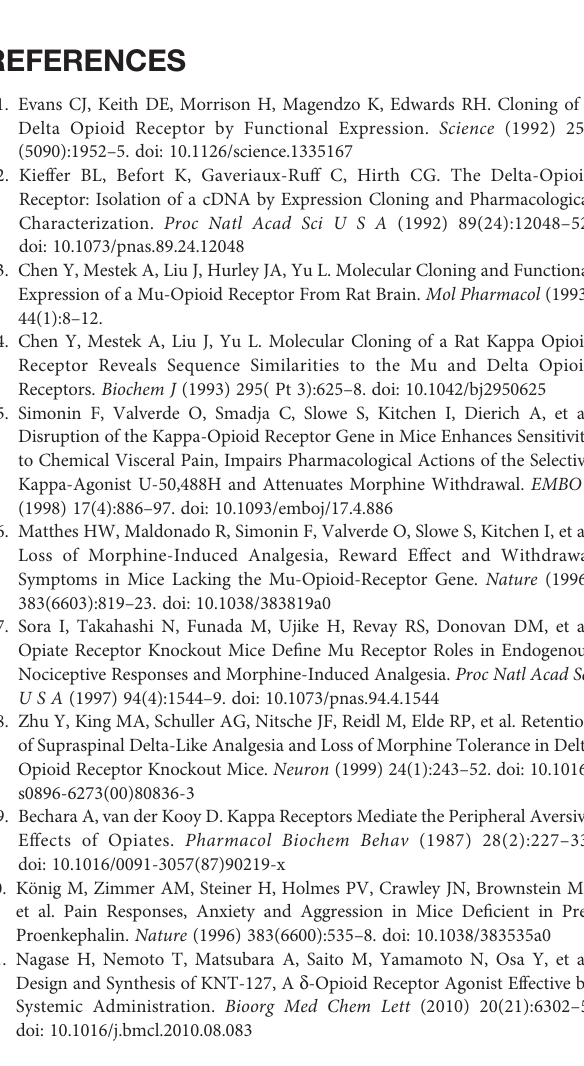
gene of interest was normalized to that of GAPDH by calculation of cycle threshold values. (A) mRNA levels of antimicrobial peptides. (B) mRNA levels of tight junction proteins. (C) mRNA levels of tissue restoration factors. The data are shown as the mean±s.e.m. ** P < 0.01; *** P < 0.001; **** P < 0.0001; n.s., not signi fi cant (one-way ANOVA followed by Dunnett ’ s multiple comparisons test, vs vehicle). Supplementary Figure 3 | Changes in intestinal factors (control mice). The colon was collected from healthy mice 24 h after treatment with 5 mg/kg KNT-127 or vehicle. The mRNA expression of each gene of interest was normalized to that of GAPDH by calculation of cycle threshold values. (A) mRNA levels of antimicrobial peptides. (B) mRNA levels of tight junction proteins. (C) mRNA levels of tissue restoration factors. The data are shown as the mean±s.e.m. n.s., not signi fi cant (Two-tailed Student ’ s t-test). Supplementary Figure 4 | Frequency of CD4+ T cell subtypes in the MLNs (colitis recovery model). The MLNs were collected from colitis mice on day 12. The frequencies of IL-6 + -, IFN-g + -, or IL-17A + -CD4 + T cells were determined by fl ow cytometry. (A) Gating strategies. (B) Typical pro fi les of fl ow cytometry (top) and frequencies of cytokine-expressing cells (bottom; n = 3). Supplementary Figure 5 | Frequency of Tregs in the MLNs of the colitis developing mice. The MLNs were collected from colitis mice on day 8. Gating strategy was same as that in Figure 4E . * P < 0.05; n.s., not signi fi cant (one-way ANOVA followed by Dunnett ’ s multiple comparisons test, vs